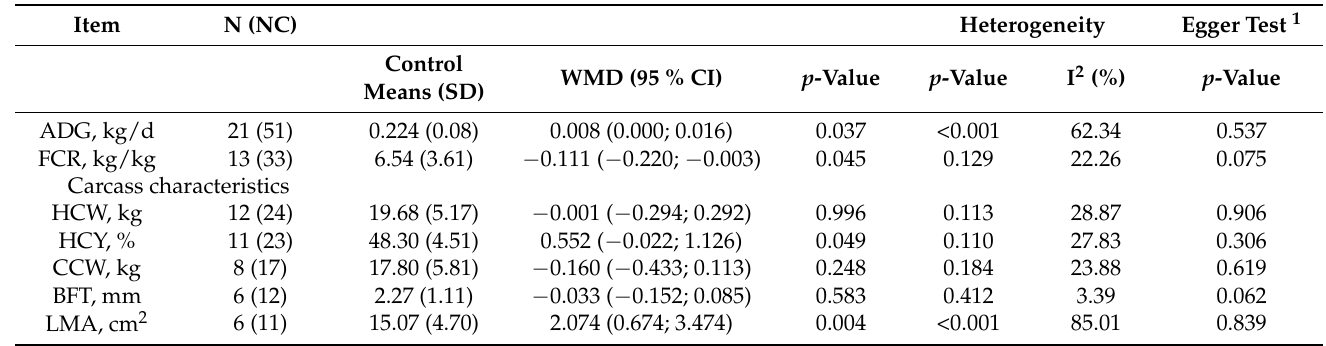
Table 3. Growth performance and carcass characteristics of small ruminants supplemented with essential